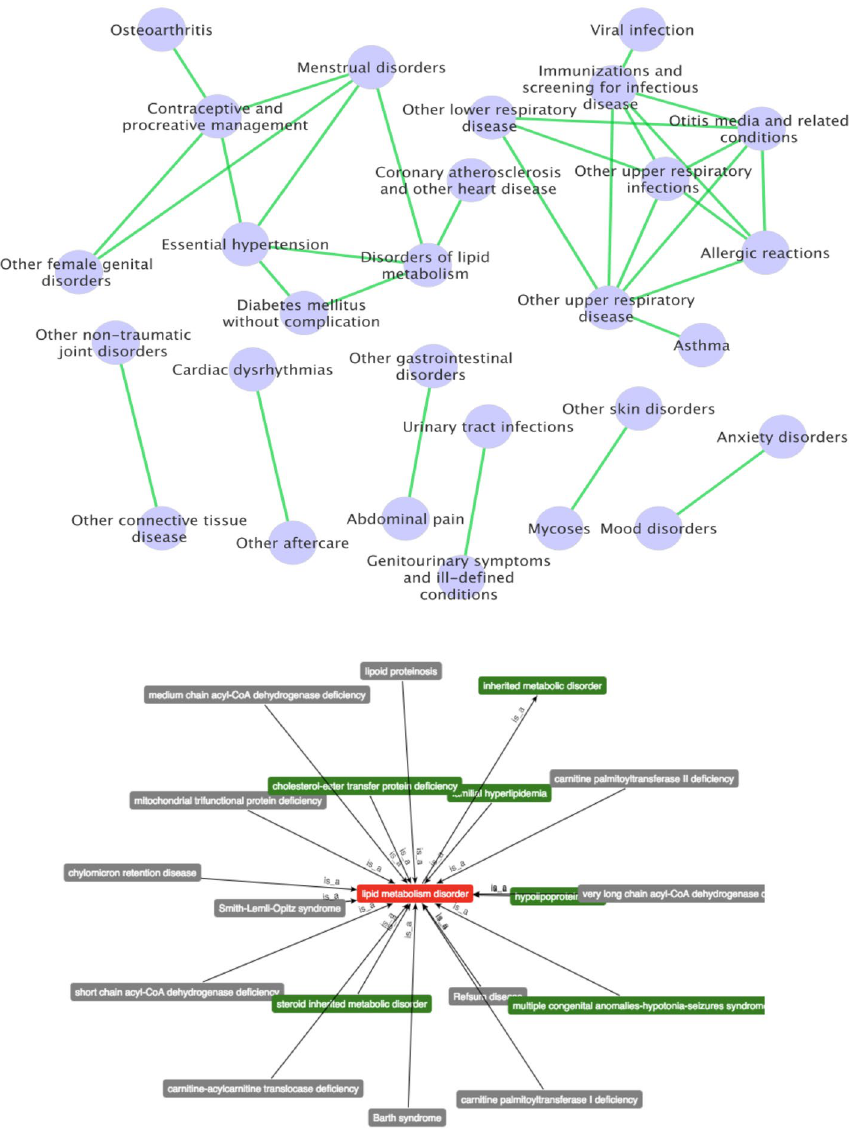
Figure 3. Network analysis of different diseases with strong correlations (top) and the network generated from Disease Ontology (DO) database for an example of disease—‘Disorders of lipid metabolism’ (bottom). The top figure was generated by using Cytoscape (version 3.7.1) software (https:// cytos cape. org/). The bottom figure was generated by using public DO database (https:// disea se- ontol ogy.